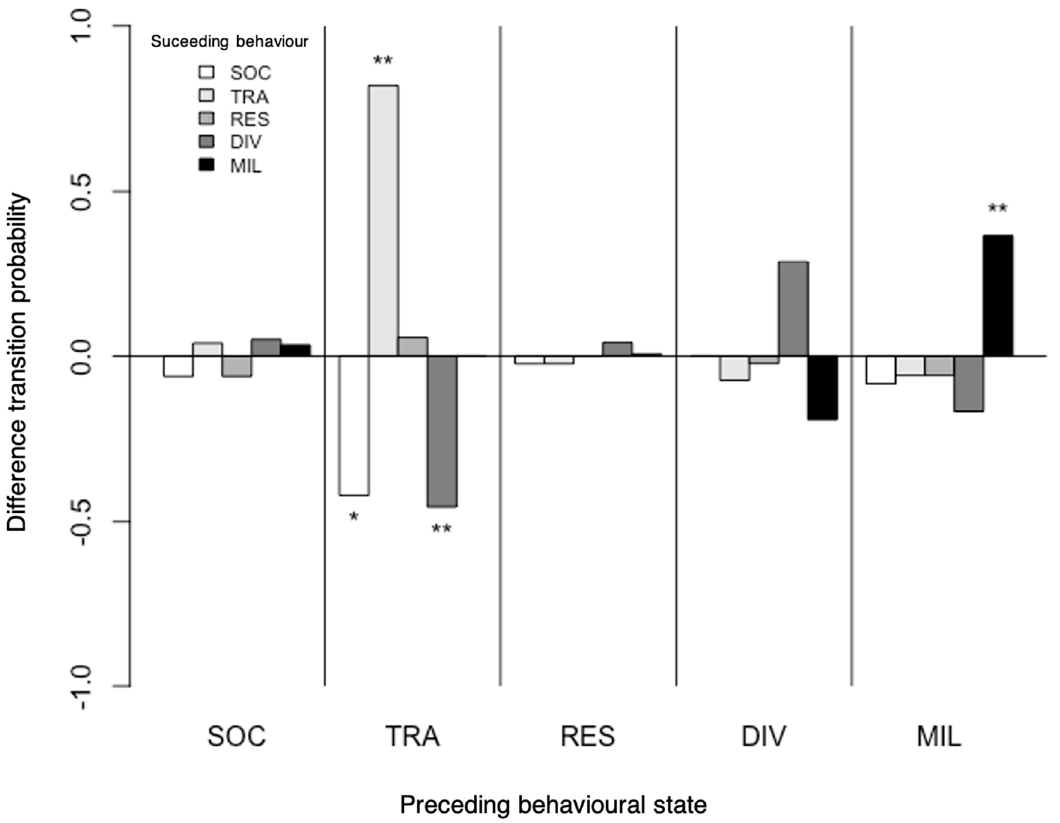
Figure 2. Difference between the transition probabilities in the behavioural states of spinner dolphins in the presence (impact) and absence (control) of vessels. A higher transition probability in impact conditions compared to control ones translates into positive values in the y -axis. Significant differences are indicated with an asterisk (* p < 0.05, ** p < 0.01). SOC: socialising; TRA: travelling; RES: resting; DIV: diving; MIL: milling.